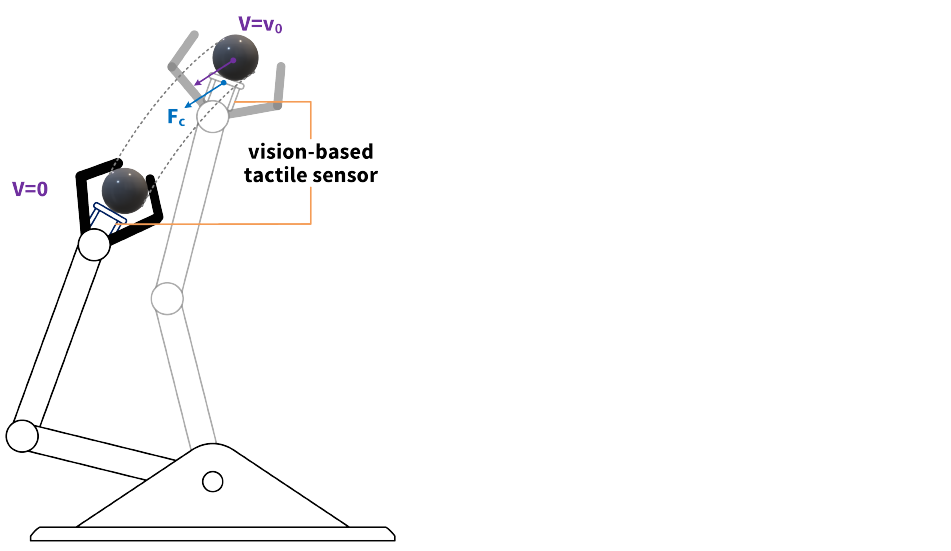
Figure 1. Soft catching. The target object contacts a vision-based tactile sensor attached to the end-effector with velocity (cid:107) V (cid:107) = v 0 and contact force F c . The velocity V decreases to 0